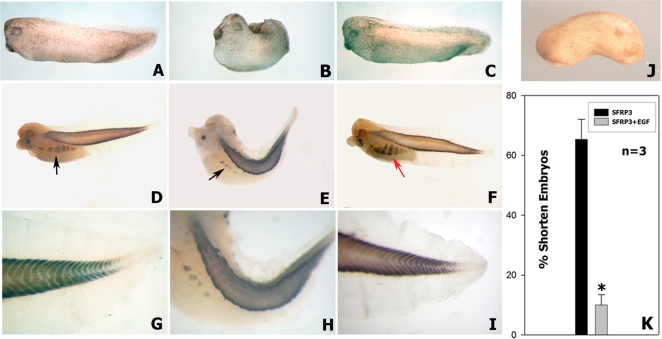
EGF specifically antagonizes sFPR-3 effects in Xenopus embryos.(A) Lateral view of a normal embryo at stage 28/29 NF un-injected. (B) Embryo injected with 4 ng of mouse sFPR-3 mRNA at stage 28/29 NF, showing a remarkable shortened of the trunk and the tail and a reduced muscle differentiation. (C) Rescue of the shortened phenotype by co-injection of 4 ng of sFPR-3 and 8 ng of EGF mouse mRNAs. (D–I) Whole mount immunostaining with 12–101 specific amphibians muscle monoclonal antibody, peroxidase detected. (D) Normal embryo un-injected at stage 35/36 NF, showing black labeling in the trunk and tail muscles and in the parietal muscle (black arrow). (E) Injected embryo with mouse sFPR-3 mRNA at stage 35/36, presenting a shortened trunk and a kinky tail; furthermore the parietal muscles (black arrow) are remarkably reduced. (F) Rescue of the shortened kinky phenotype, showing completely restored muscle differentiation also in the parietal muscle (red arrow). (G–I) High power magnification respectively of D–F, showing in detail the chevron like organization of the tail muscles of un-injected normal larvae (G), missing in the sFRP-3 treated tadpole tail (H) and restored in the co-injected larvae with EGF mouse mRNA (I). (J) Lateral view of a co-injected embryo with 4 ng of sFRP-3 and 8 ng of FGF-8 mouse coding mRNAs, showing no rescue of the sFRP-3 phenotype. (K) Quantization of multiple injections (n = 3) showing the rate of the phenotype rescue by co-injection with 8 ng of EGF mouse mRNA after the injection of sFPR-3 (asterisk indicates statistical significance P<0.001).